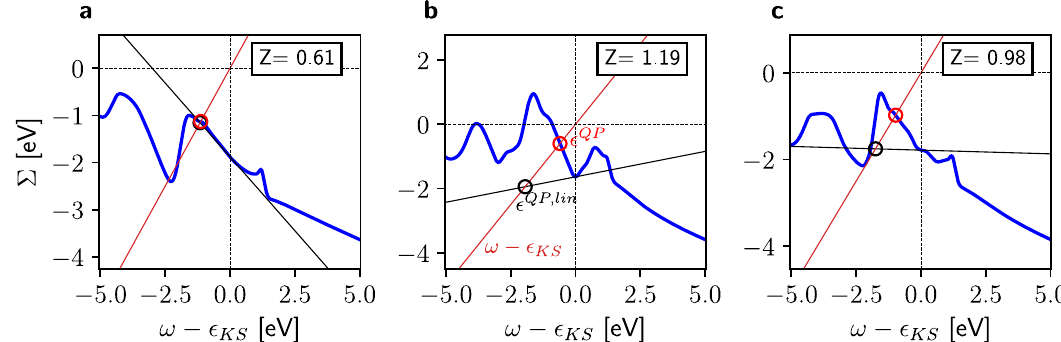
Fig. 4 Self-energies and the linear approximation. Frequency-dependent self-energy (blue) for three electronic states with different quasiparticle weights, Z . The red line indicates ω − ϵ KS while the black line is the linear approximation of the self-energy. The intersection of the blue and red lines indicate the solution to the quasiparticle equation, while the intersection between the red and black lines indicate the solution given by the linear approximation to the self-energy. Table 1. Properties of test materials summary of the 12 materials used to study the frequency-dependent self-energy.